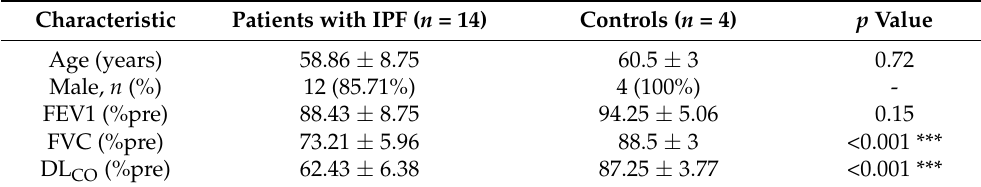
Demographic and clinical characteristics of controls and patients with IPF (lung tissue